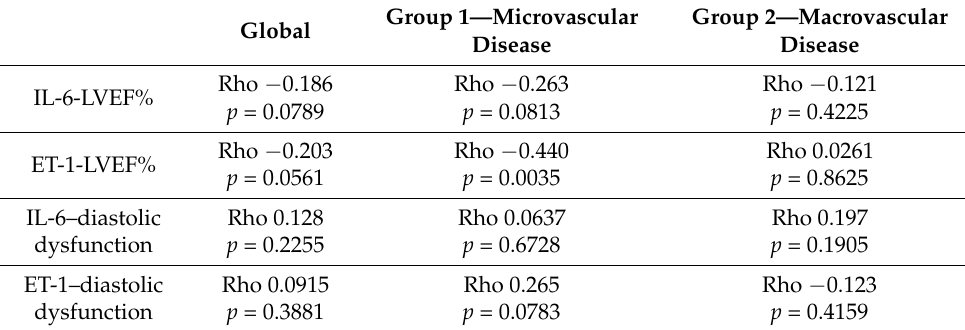
Table 4. The correlation between the IL-6/ET-1 value and left ventricular function. Group 1—Microvascular Global